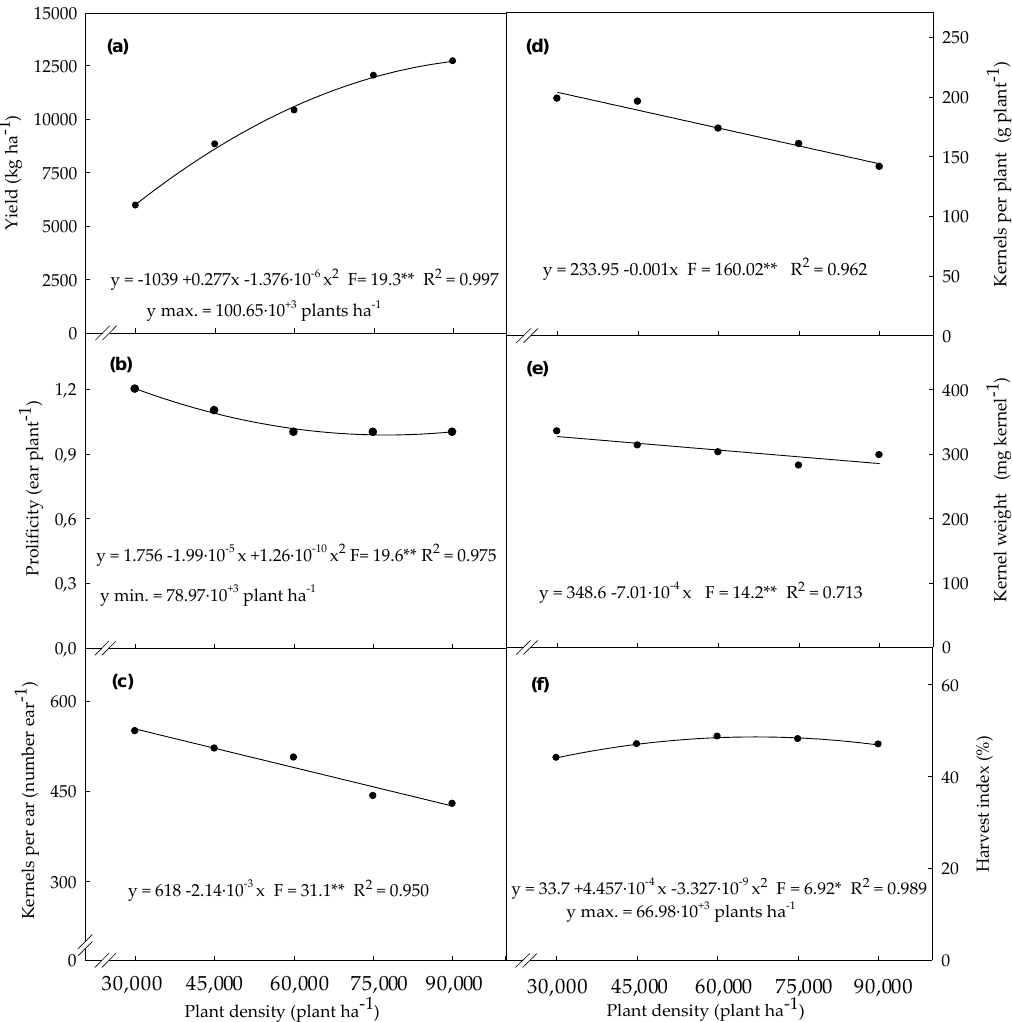
Figure 5. Yield ( a ), prolificity ( b ), number of kernels per ear ( c ), production of kernels per plant ( d ), kernel weight average ( e ), and harvest index ( f ) of corn plants at final harvest time as a function of the plant density. Plant density in the field ranged from 30,000 to 90,000 plants per hectare. Statistical data were obtained from four field replications. F = F test result of the regression analysis; (*) and (**) indicate that the F test revealed statistical significance at p ≤ 0.05 and p ≤ 0.01, respectively; R 2 = determination coefficient.